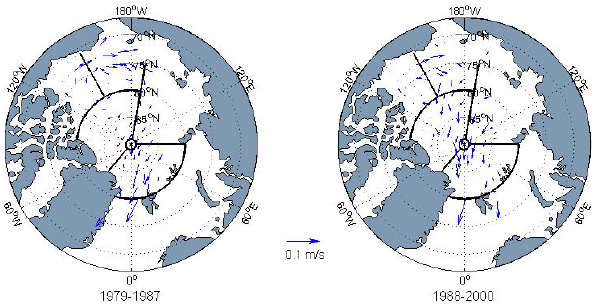
Fig. 7. Mean sea ice drift during the periods 1979–1987 and 1988–